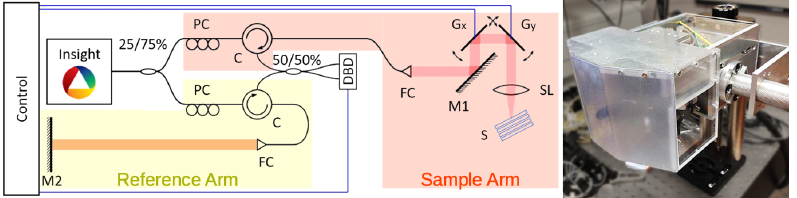
Figure 1. OCT setup: Insight: 1300nm swept-source; 25/75% fiber coupler; PC: polarization control; C: circulator; 50/50% fiber coupler for light recombination; FC: fiber collimator; M1, M2: mirrors; Gx, Gy scanning galvanometers; SL: scan lens; S: sample; DBD: dual-balance